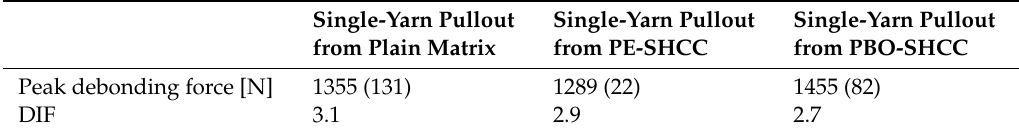
Table 9. Peak debonding force obtained from high-speed pullout tests with three di ff erent matrices (average values; standard deviations are given in